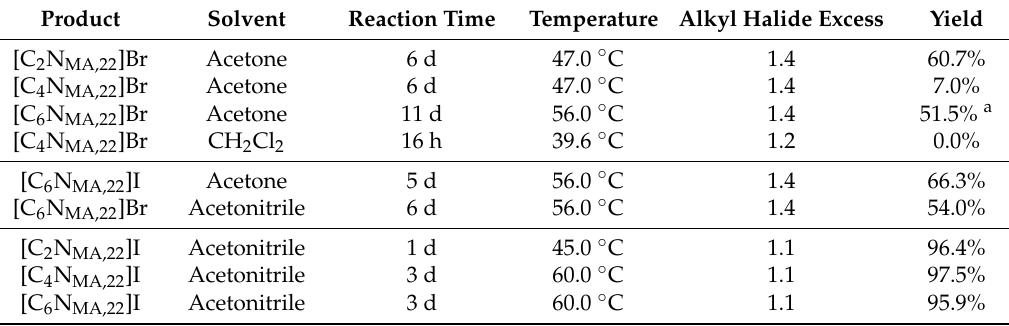
Table 1. Selected reaction conditions and yields of the intermediate products.